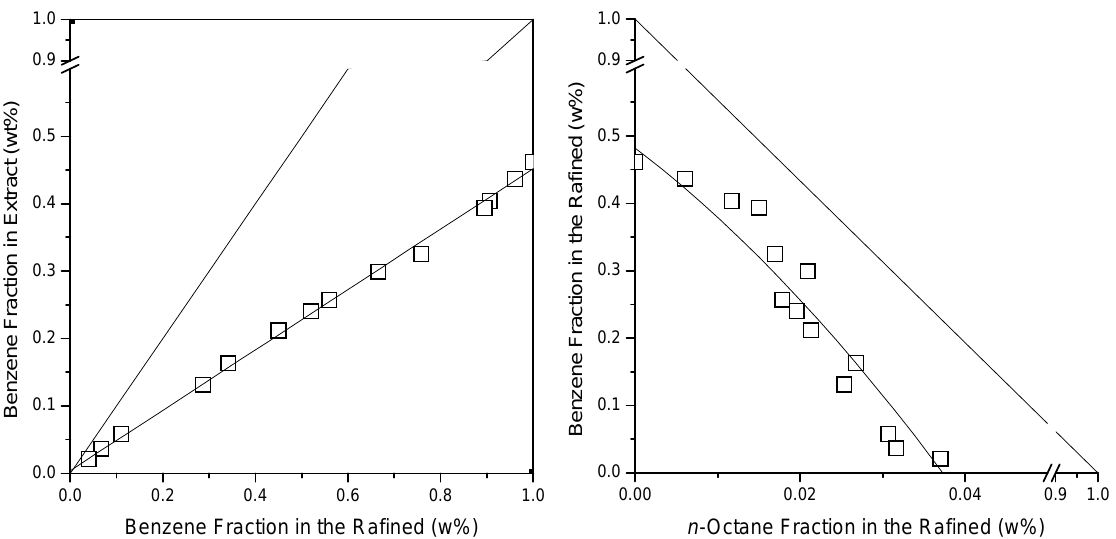
Figure 5. Liquid-liquid phase diagram of BMI.N(Tf) /benzene/ n -octane at 25 °C in right triangle 2 shape. The main chart is shown at right evidencing the extract composition line which divides the chart into the single (under that line) and two phases (over that line) regions. The raffinate composition line is located over the triangle diagonal, since the amount of ionic liquid can be neglected therein. The left chart relates the composition of benzene in the extract and in the raffinate.